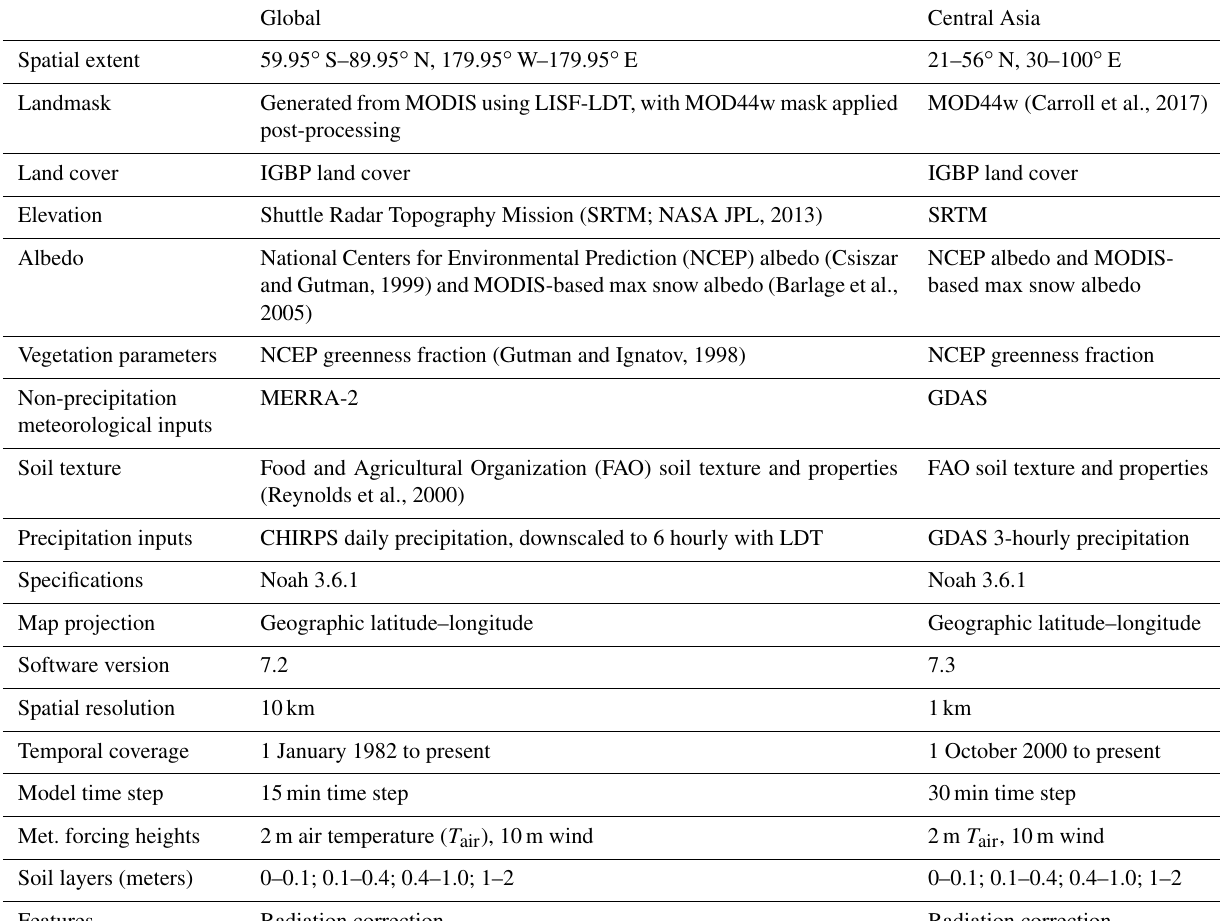
Table 1. FEWS NET Land Data Assimilation System (FLDAS) specifications for (a) global data stream, 10km, monthly with CHIRPS and MERRA-2 and (b) Central Asia data stream, 1km, daily with